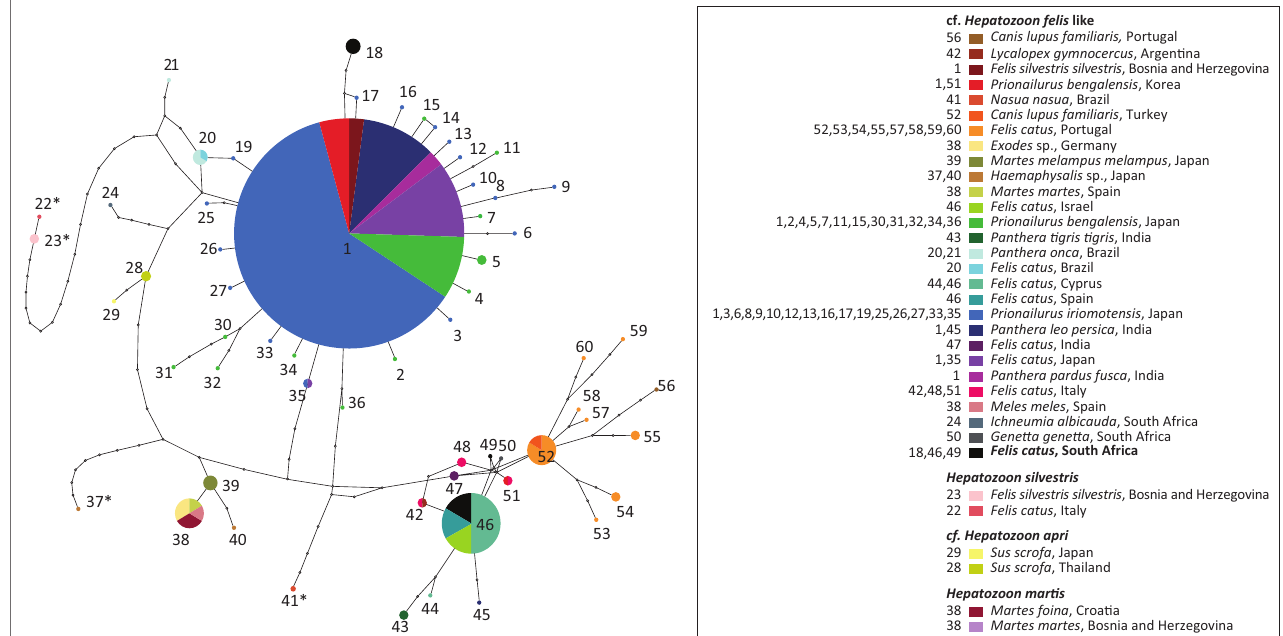
FIGURE 2: Network showing relationships between haplotypes of Hepatozoon felis and other closely related species. Those marked with an aterisk ( * ) could not be linked to the network with 95 % confidence using the TCS methodology. Size of circles represents numbers of haplotypes, and small open circles inferred missing haplotypes. Three haplotypes from South African cats are shown in black and